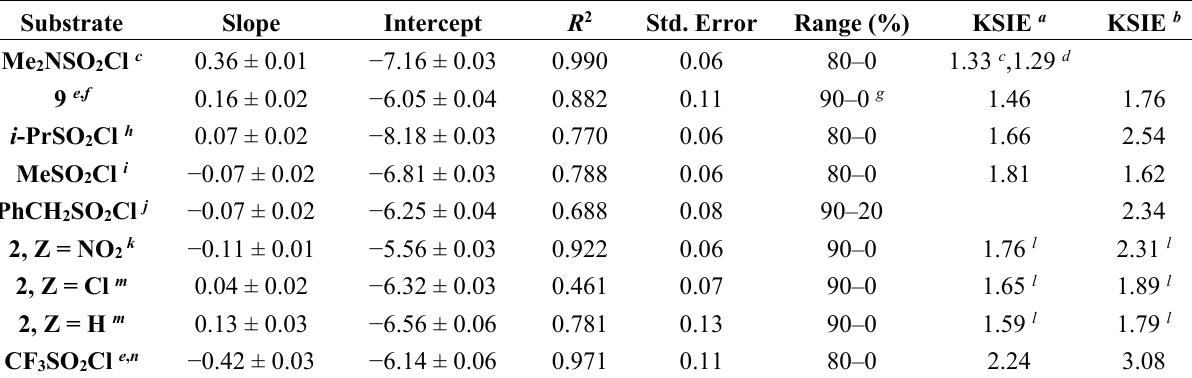
Table 2. Correlations Equation (3) for acetone-water (% v / v ) and kinetic solvent isotope effects (KSIE) in water and methanol for solvolyses of sulfonyl chlorides at 25 °C (unless stated